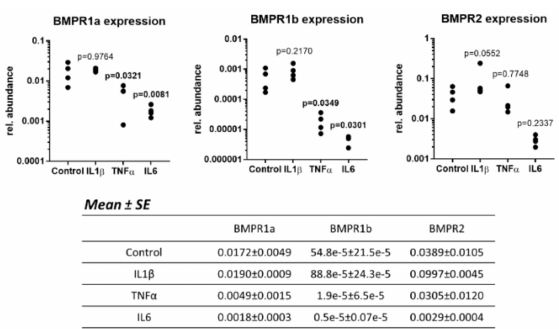
Figure 6. Human OA chondrocytes were cultured in a monolayer for two days in the presence of 10 ng / mL IL1 β , 10 ng / mL TNF α or 100 ng / mL IL6 at 380 mOsm. Afterwards, the gene expression of BMPR1a, b and BMPR2 was evaluated by RT-qPCR. Data on the graphs represent the mean of technical replicates ( n = 3–6). Statistical analysis was performed on biological replicates ( n = 4 donors). p values are shown on the graphs and are bold when p ≤ 0.05, the means and standard errors (SE) of the mean are tabulated below the